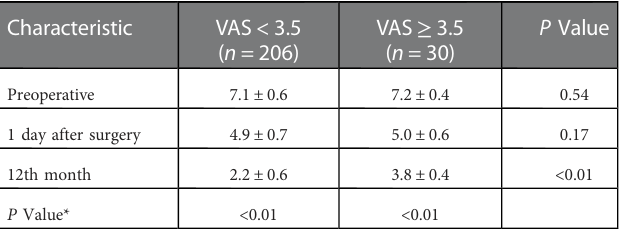
TABLE 1 Low back pain VAS results at the 12th